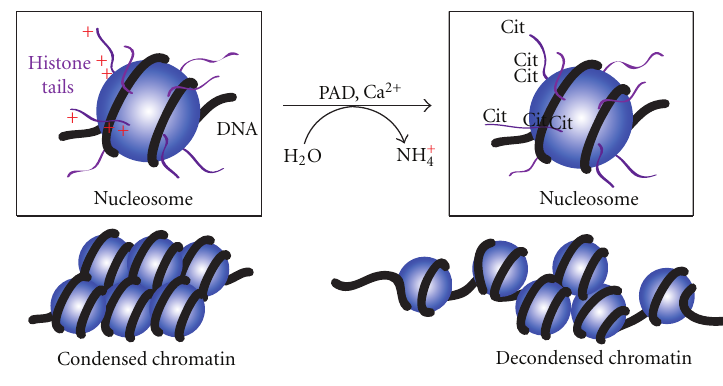
Figure 2: PAD-mediated histone tail citrullination leads to chromatin